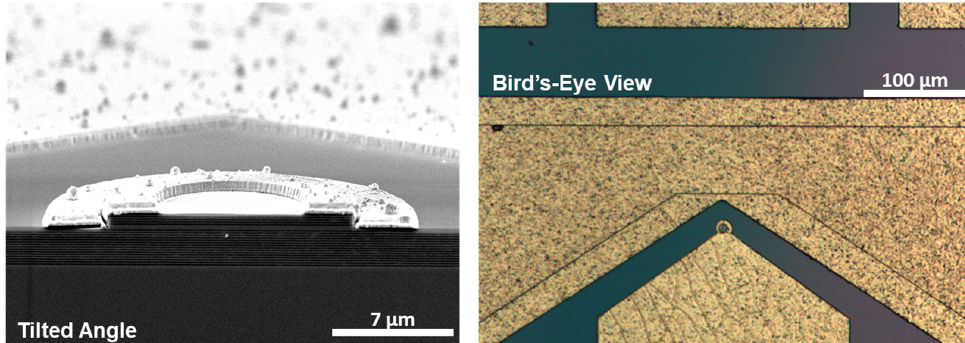
Figure 8. ( Left ) Scanning electron microscopy image of the cavity-enhanced RTD photodetector in ring-contact geometry taken at tilted angle. Electron microscopy image of an RTD photodetector with intracavity ring-shaped contacts. ( Right ) Optical microscopy image of the surface of the sample. The circular shaped contact is clearly visible.